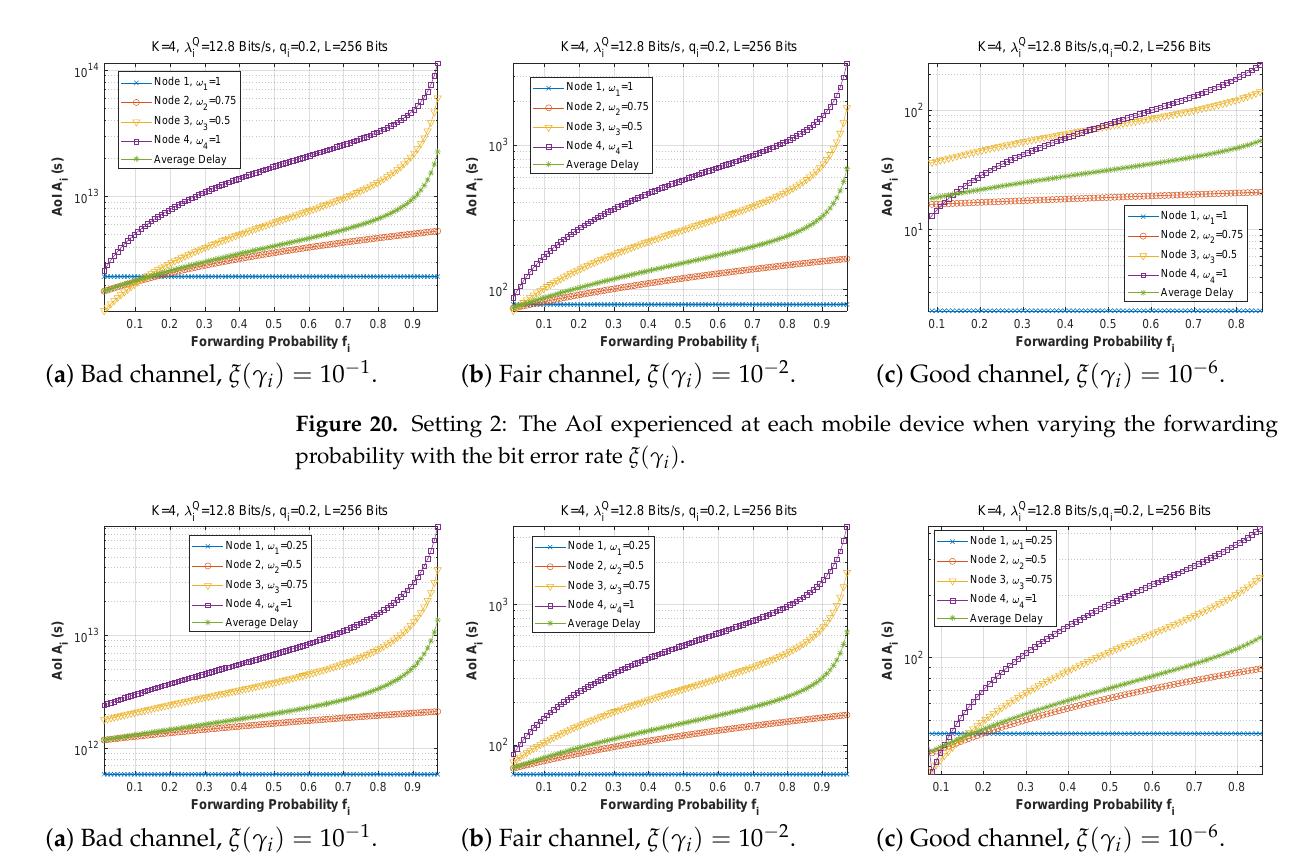
Figure 21. Setting 3: The AoI experienced at each mobile device when varying the forwarding probability with the bit error rate ξ ( γ i ) .